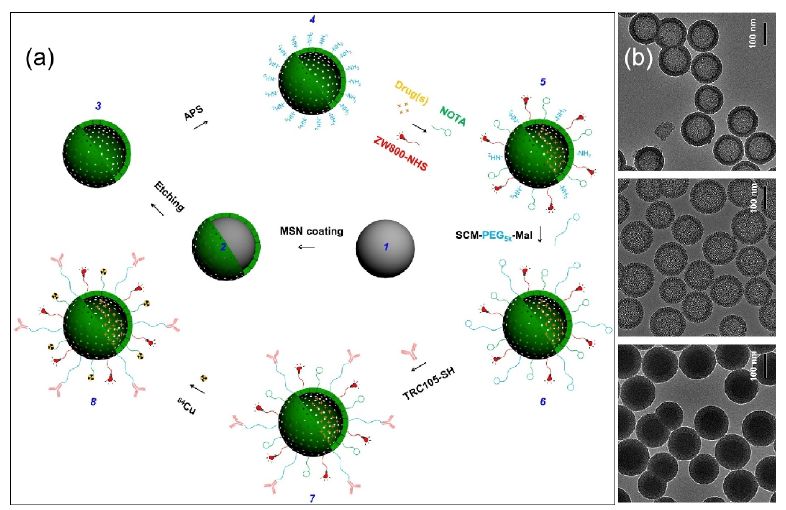
Figure 7. ( a ) Scheme of surface engineering hollow mesoporous silica nanoparticles; ( b ) TEM images of the corresponding nanoparticles. Reproduced with permission from Ref. [109], Copyright 2014, Springer